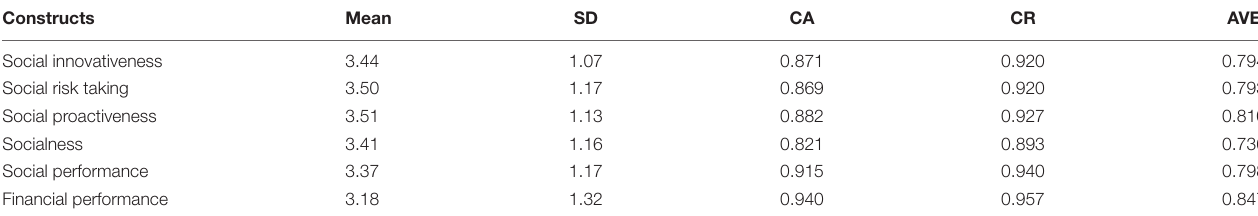
TABLE 3 | Mean, standard deviation, Cronbach alpha, composite reliability, and average variance extracted.